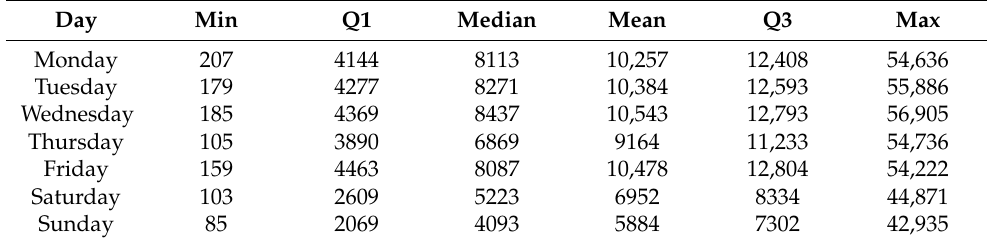
Table 1. Passenger flow at stations per day of the week.